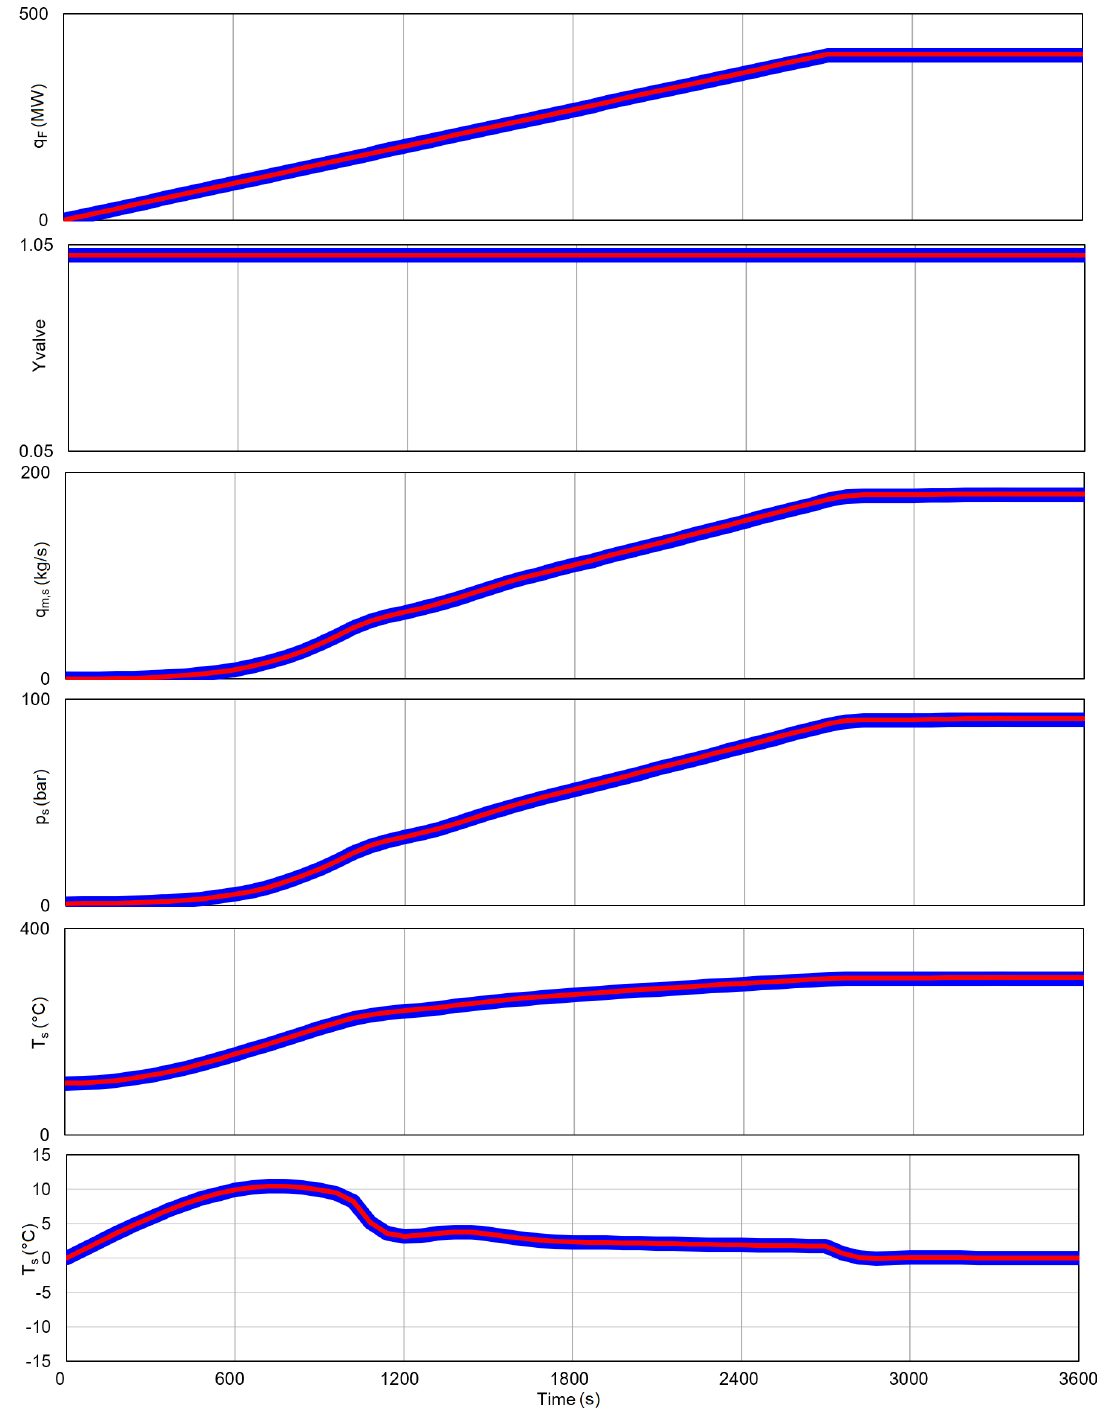
Figure 14. Drum boiler simulation results. Belkhir et al. [20] (blue line); proposed approach (red line). The optimization problem focused on the design of an optimal drum boiler startup profile with its corresponding control valve operation sequence. The objective was to achieve a given state in terms of steam temperature and pressure in the shortest time possible. Based on the work of Belkhir et al.